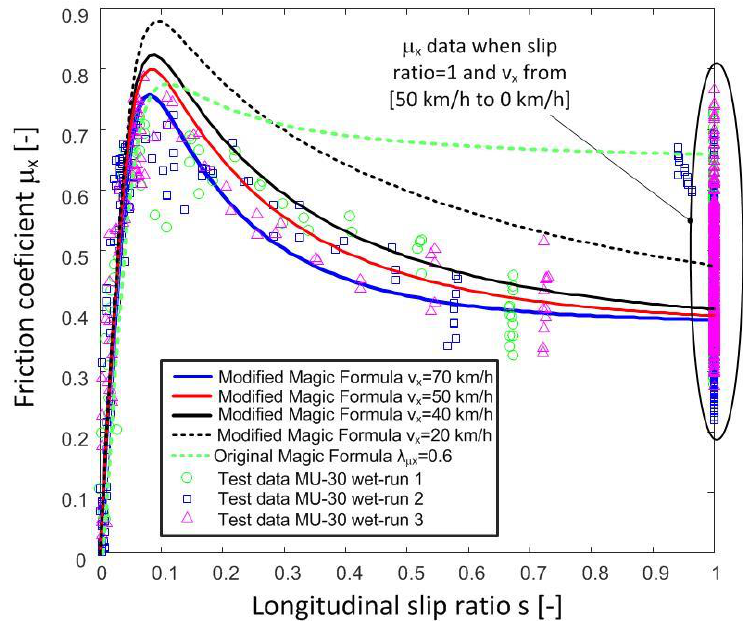
Figure 6. Longitudinal friction coefficient versus slip with different speeds. Highway MU-30. Modified model of the Magic Formula.